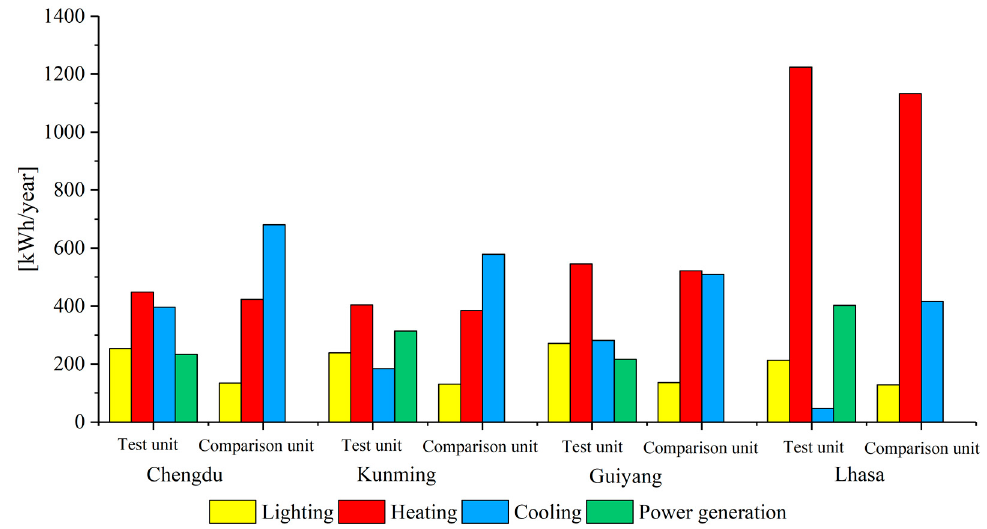
Figure 8. Energy consumption for two units in different cities.